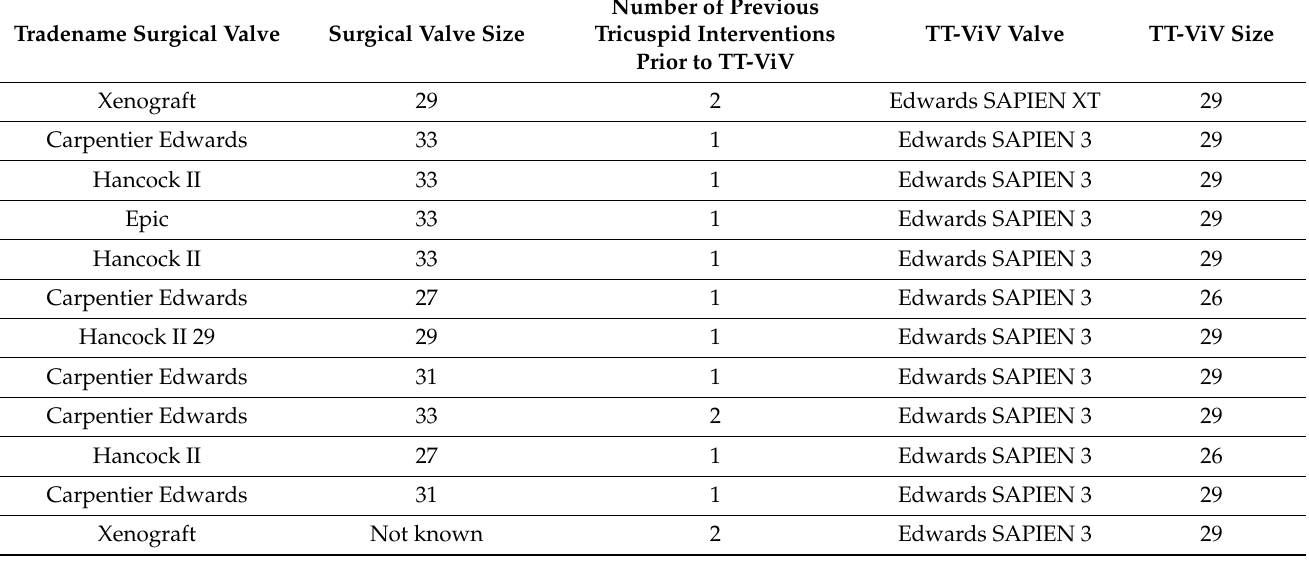
Table 3. Bioprosthetic valve type and size and their corresponding transcatheter valve devices.